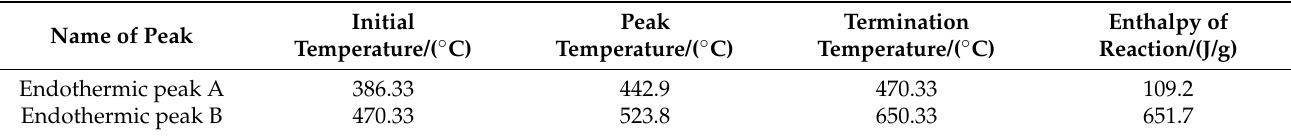
Figure 6. TG/DSC curve of TiH 2 pyrolysis process. A and B: Endothermic peak. Table 7. Parameters of peak A and peak B on DSC curve of TiH 2 .